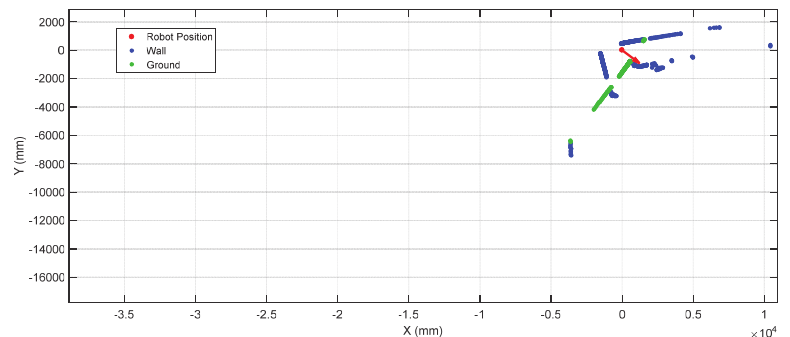
Figure 15. Image of the mobile robot APR-03 at the stair area of the facility.